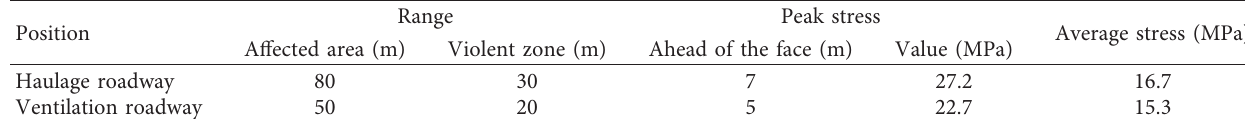
Figure 10: Working resistance of the single prop in front of the working face. (a) Monitoring curves of the single prop 50m ahead of working face. (b) Monitoring curves of the single prop 100 m ahead of working face. (c) Monitoring curves of the single prop 150m ahead of working face. Table 2: The influence range and value of lead abutment